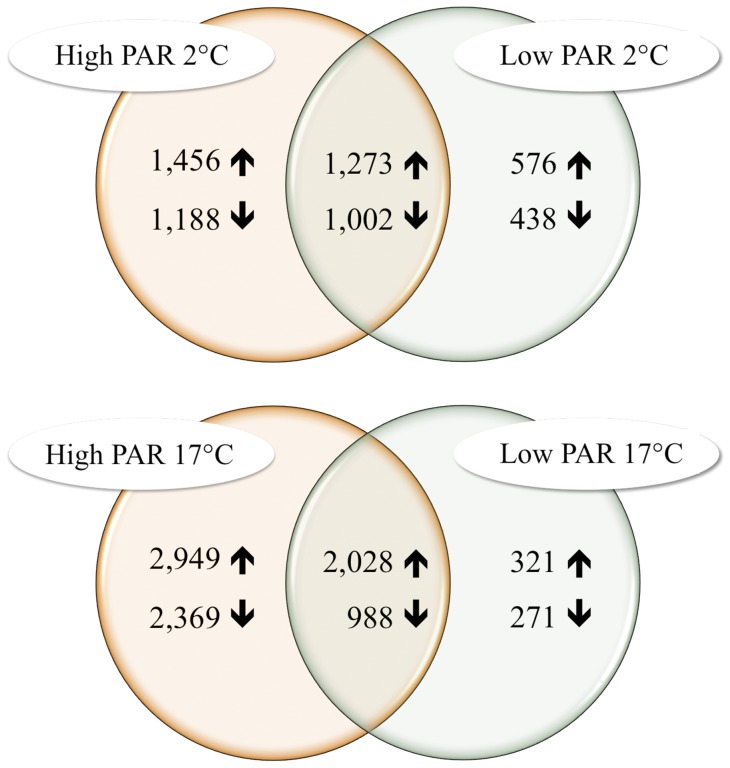
Venn diagram of responsive ESTs after 24 h exposure to different light and temperature conditions.Numbers of responsive ESTs in S. latissima after exposure to different experimental conditions. Regulated transcripts are seperated in up (↑) and down (↓) regulated ESTs. The intersections display the number of ESTs regulated in both treatments.